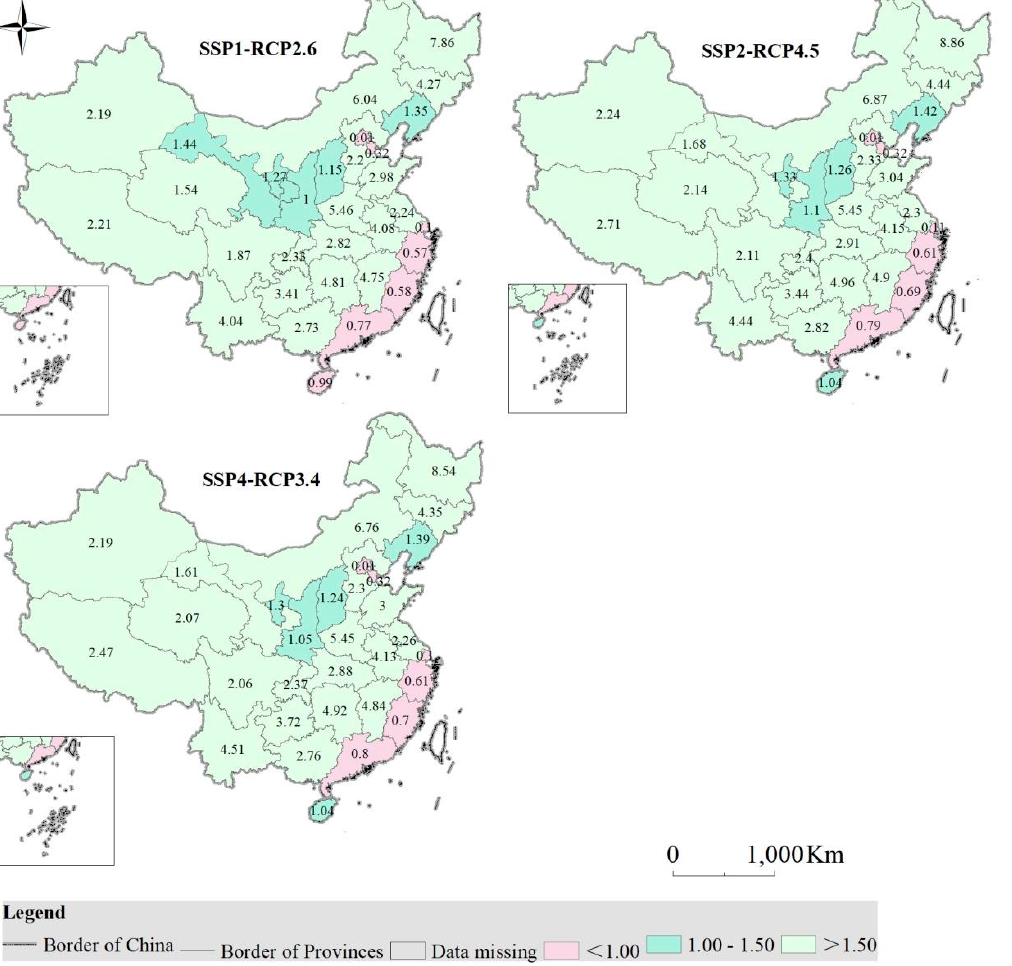
Figure 6. Guarantee rate of cropland in China in 2030 under three scenarios, and the value (unit: 100%) in the map stands for the guarantee rate of cropland in each province.